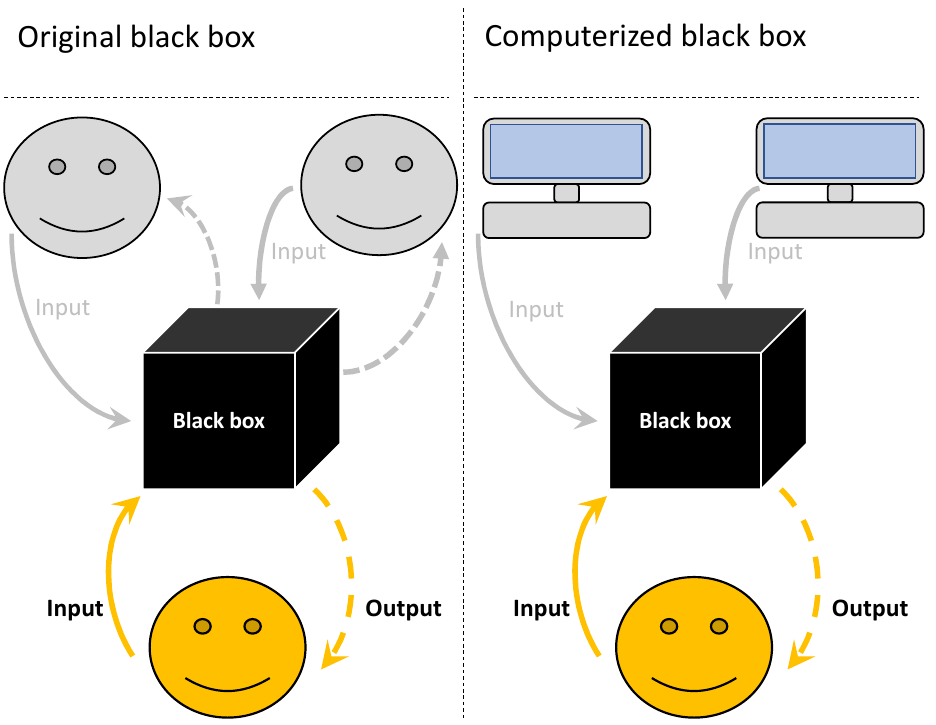
Figure 1. Black box methodologies. In the original black box, participants are connected online and interact in the usual experimental manner for economic games. However, by “black-boxing” the social aspect of the game or the game’s rules and payoffs, one can investigate how participants learn under certain conditions. If one is concerned about individuals affecting either the learning or the payoffs of other participants, one can replace the focal player’s interaction partners with programmed computerised/virtual players (computerised black box). This also allows for more control over the learning environment, as partners can be programmed to be more/less cooperative,